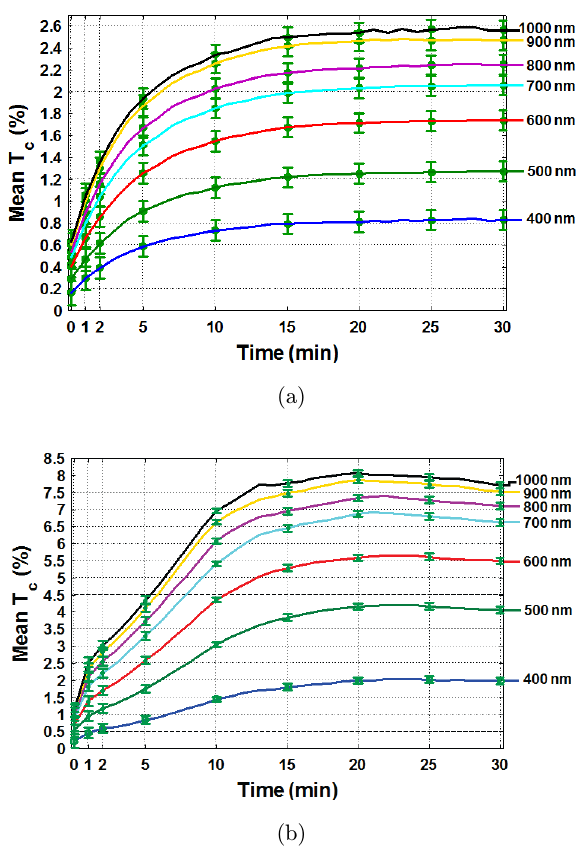
Fig. 7. Mean time dependence (mean of three studies) of T c for some wavelengths for the treatments with: (a) 40% glucose; (b) 99%